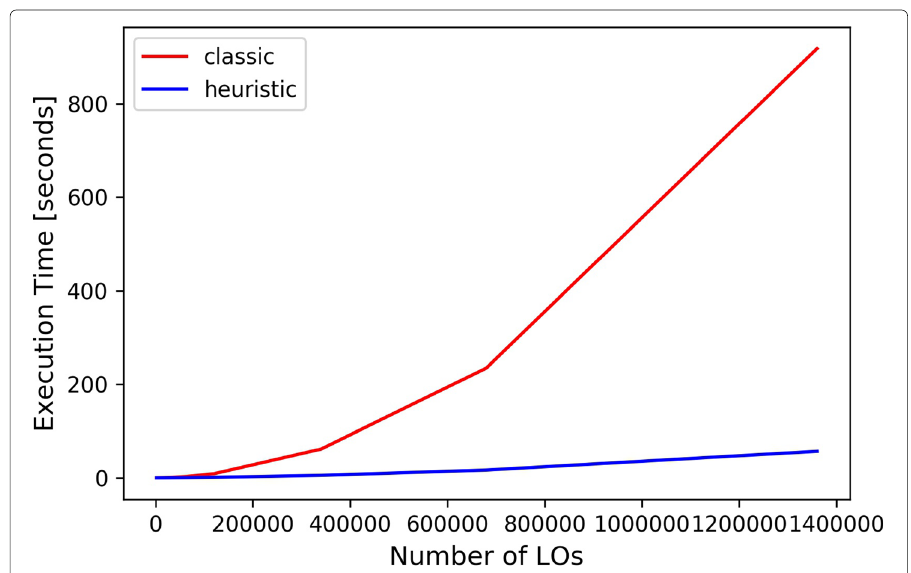
Fig. 4 Average response time of the proposed heuristic in relation to the classical algorithm